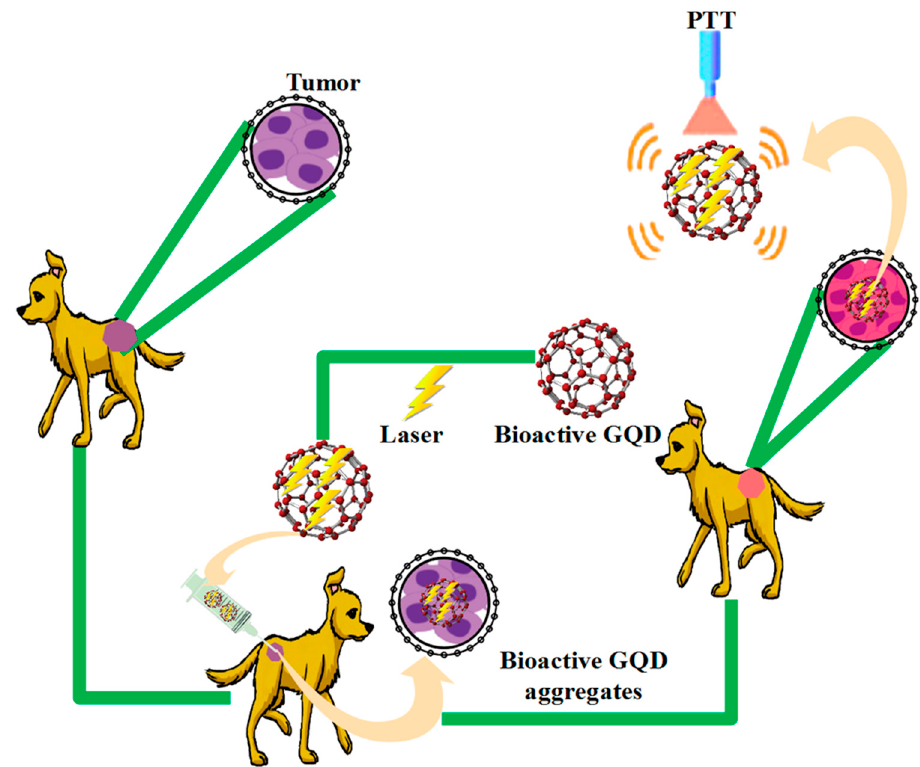
Figure 9. Tumor treatment with the PTT method based on bioactive